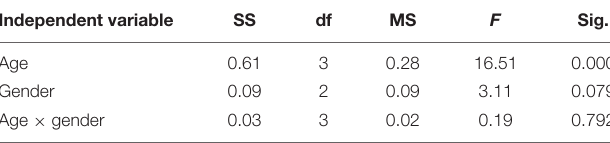
TABLE 3 | Test results of the main effect of age on children’s emotion recognition. Independent variable